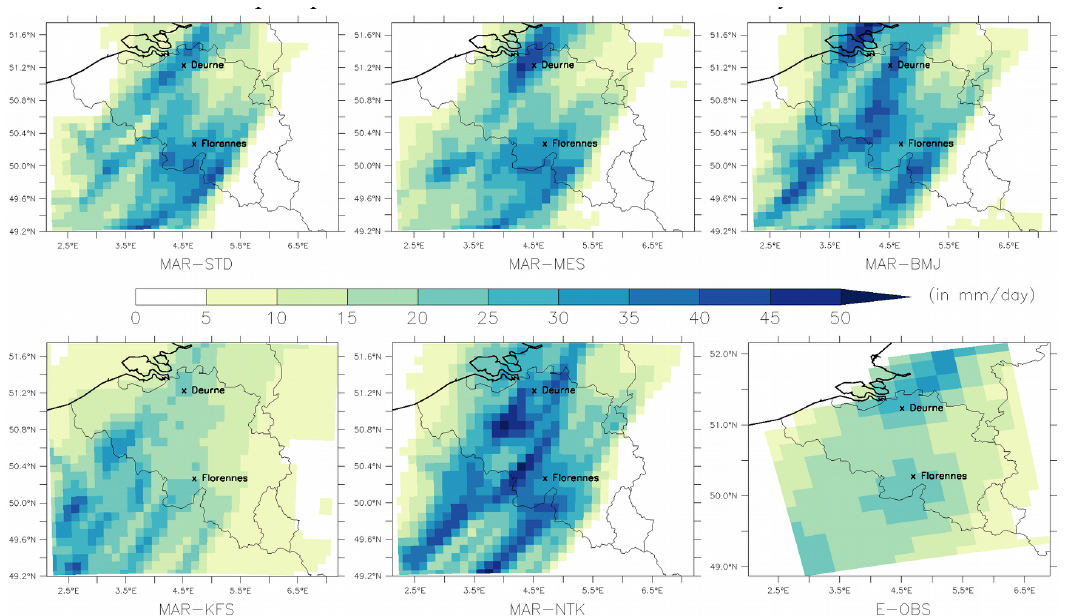
Figure A2. Precipitation simulated by MAR for each experiment and provided by E-OBS on the 22 May 2016 (in mm/day).